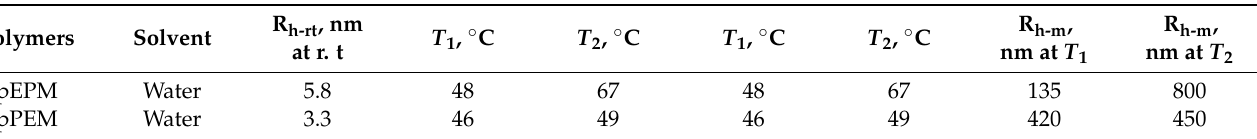
Figure 12. Effect of polymer concentration on the phase separation temperature T pt for pPEM. Table 3. The phase separation temperatures and hydrodynamic characteristics of aggregates of polymer solution at concentration = 0.005 g∙cm −3 .